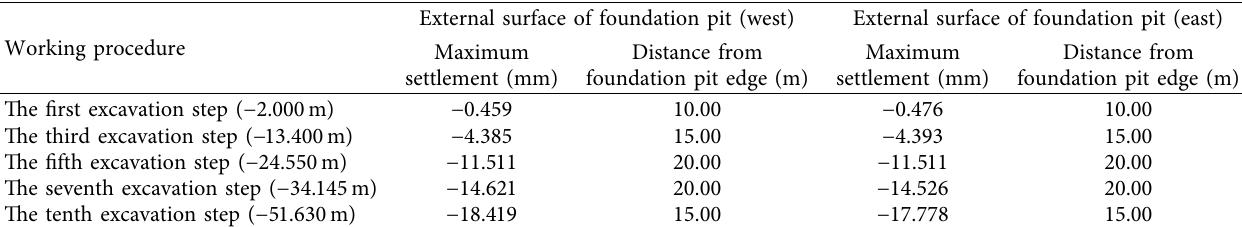
Figure 17: The curve of the surface settlement of the suspended foot diaphragm wall. (a) West wall. (b) East wall. Table 9: Summary of the corresponding position of the maximum subsidence of the surface.